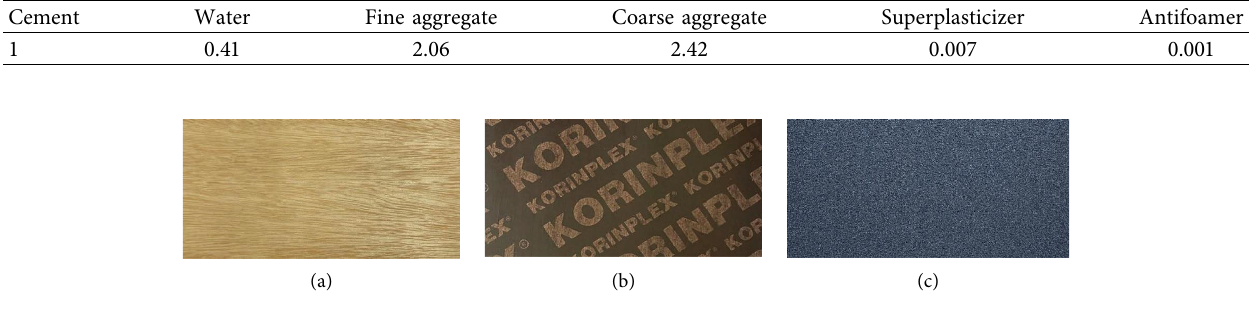
Table 1: Mixture proportions (proportion by weight).